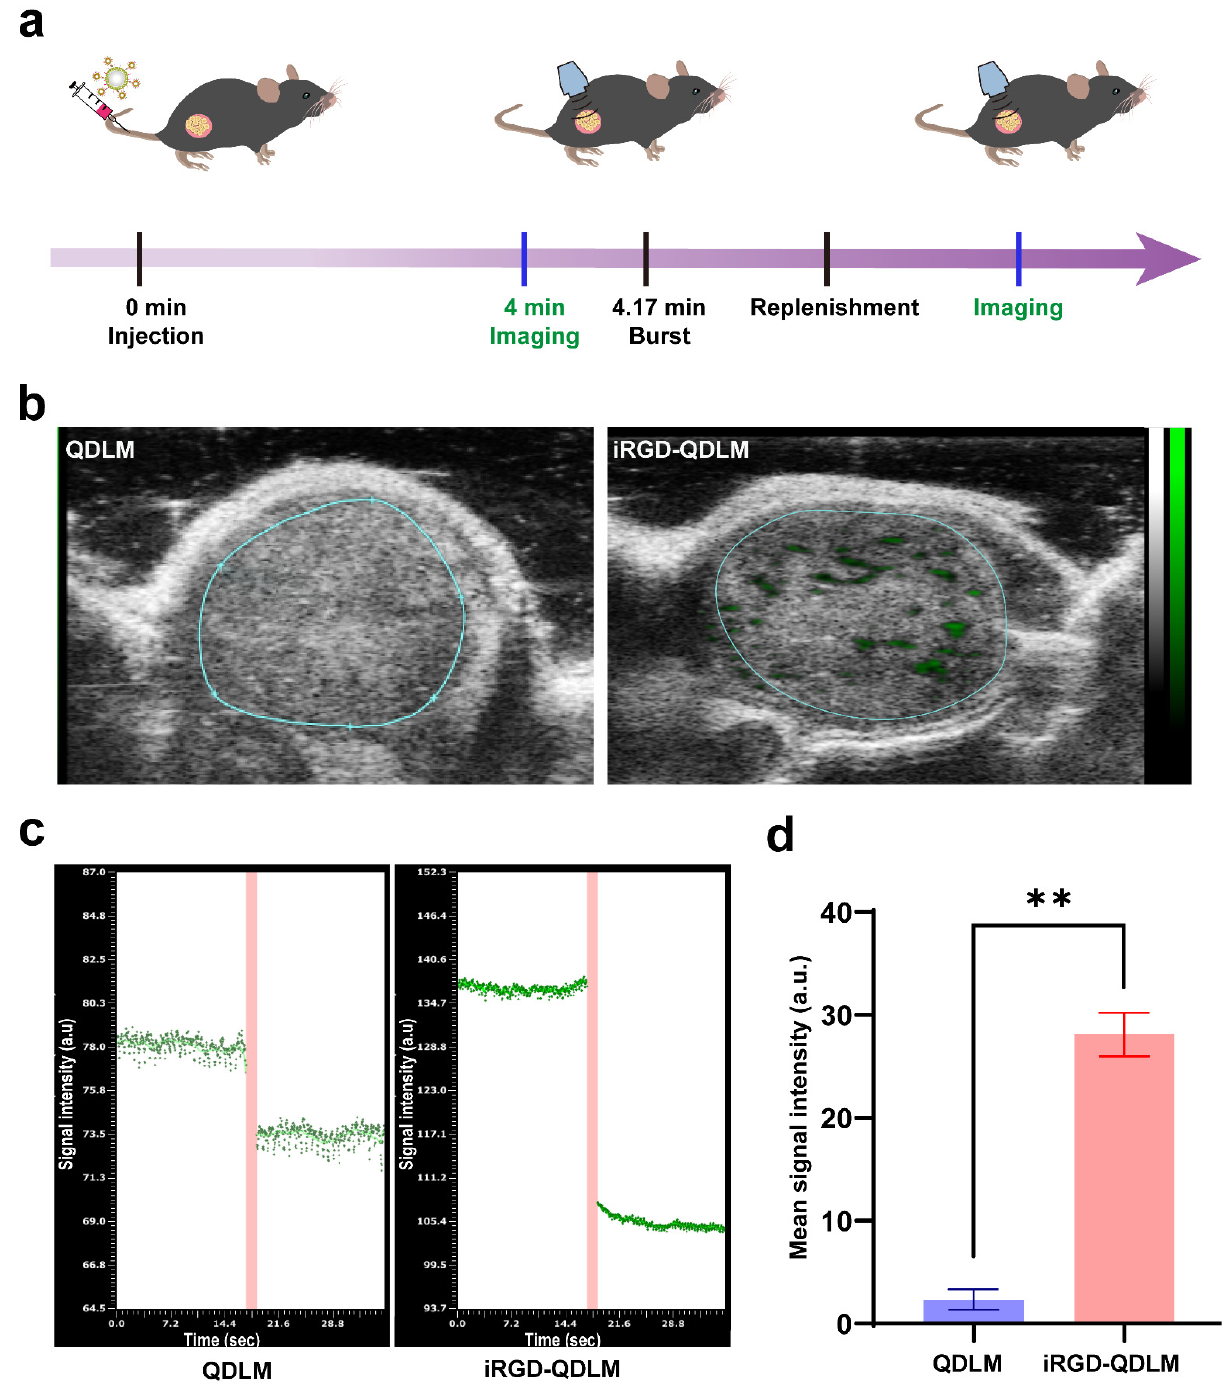
Figure 4. In vivo ultrasound molecular imaging of iRGD ‐ QDLM in the tumor blood vessels. ( a ) Schematic diagram of experimental procedure in a tumor ‐ bearing mouse. ( b ) B ‐ mode image with overlaid non ‐ targeted (QDLM) and α v β 3 ‐ integrin ‐ targeted (iRGD ‐ QDLM) ultrasound molecular imaging signals. Green signals represent iRGD ‐ QDLM attached to the tumor vessel. n = 5 mice in both iRGD ‐ QDLM and QDLM groups. ( c ) Representative time–signal intensity curves for the region of interest after injection of QDLM and iRGD ‐ QDLM. ( d ) Quantitative analysis of the difference signal intensities of the QDLM and iRGD ‐ QDLM by a destruction/replenishment approach. ** p < 0.01.